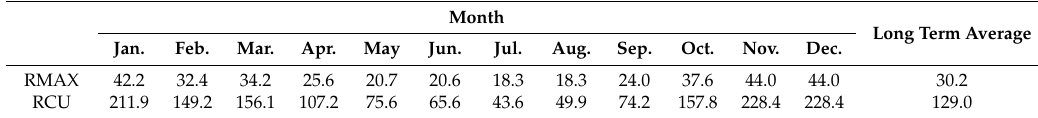
Table 2. Long term average for RMAX and RCU per mm based on the historical records of the observed data in Vancouver Harbour CS gauge station.